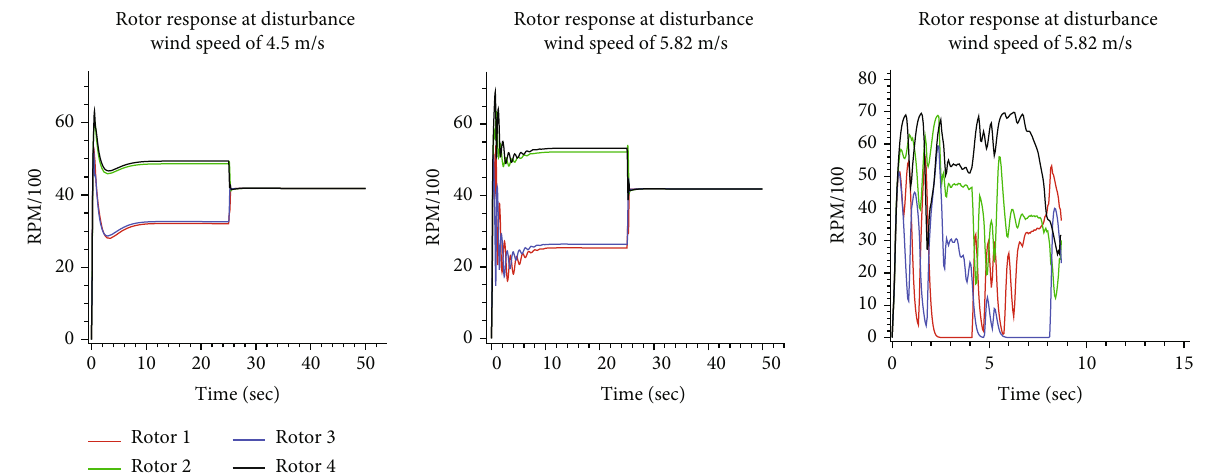
Figure 24: Rotation speed of each rotor at di ff erent disturbance crosswind speeds.